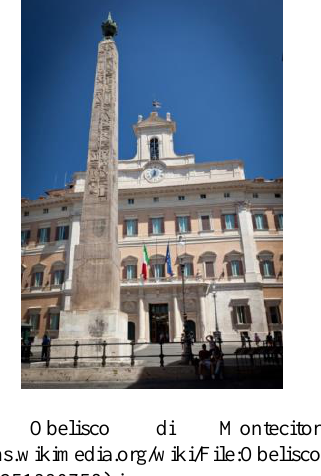
Figure 8: Obelisco di Montecitorio